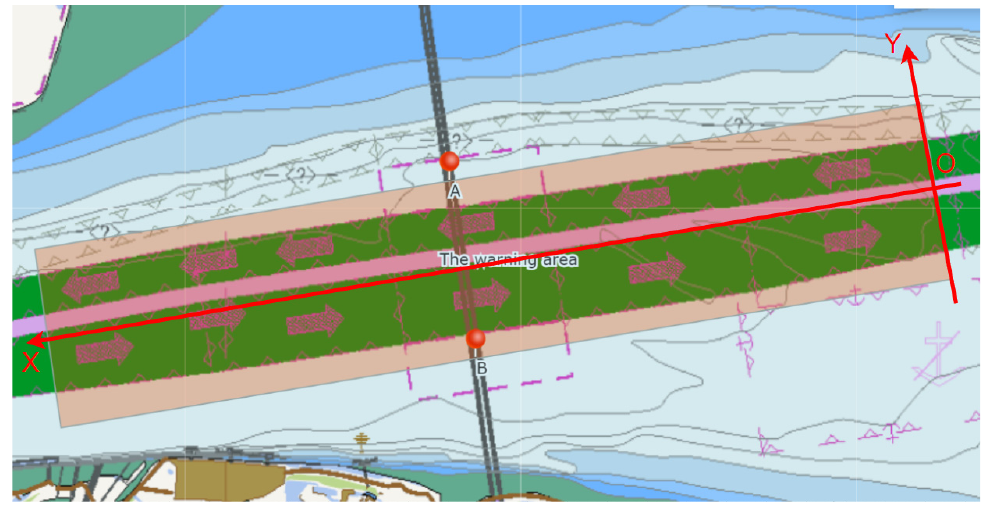
Figure 7. Establishment of the selected range coordinate system.